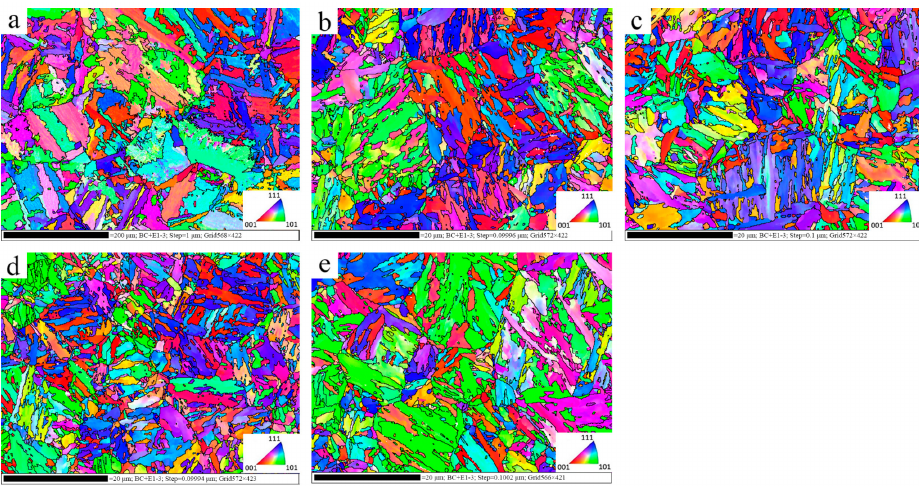
Figure 13. The orientation maps for ( a ) BM, ( b ) HDL, ( c ) HDT, ( d ) CFL, and ( e )